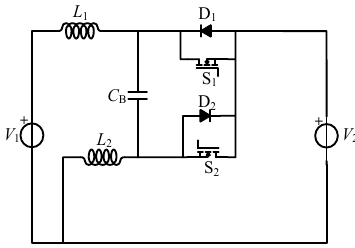
Figure 1. Bidirectional Cuk circuit.